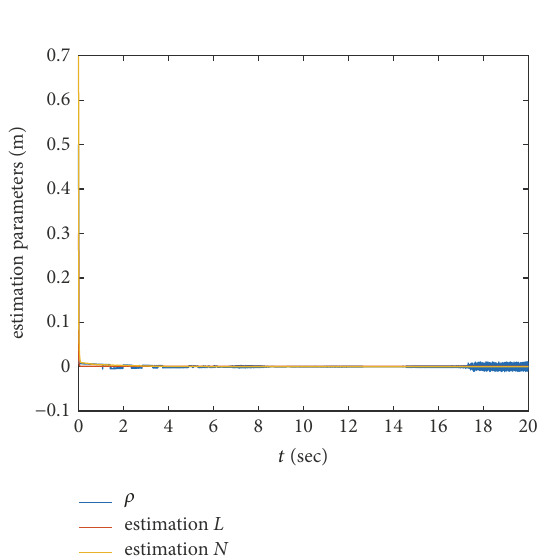
Figure 3: The time response of estimation of parameters.